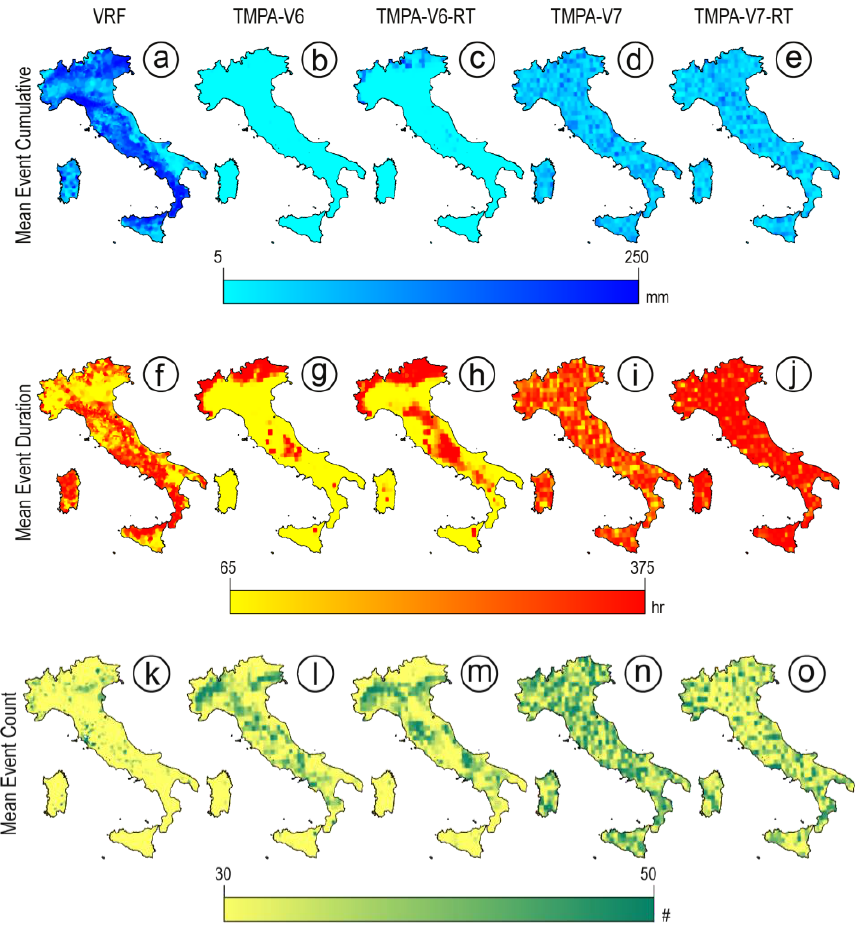
Figure 18. Maps of mean cumulative rainfall (1st row), mean rainfall event duration (2nd row), and mean number of events (3rd row) detected by the automatic procedure in the entire Italian territory in the period September 2009–August 2010 for the VRF data ( a , f , k ) and for the TMPA-V6 ( b , g , l ), TMPA-V6-RT ( c , h , m ), TMPA-V7 ( d , i , n ), TMPA-V7-RT ( e , j , o ) satellite rainfall estimates.